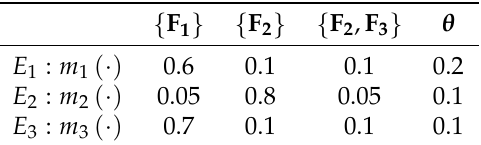
Table 1. Basic belief assignments (BBAs) for the